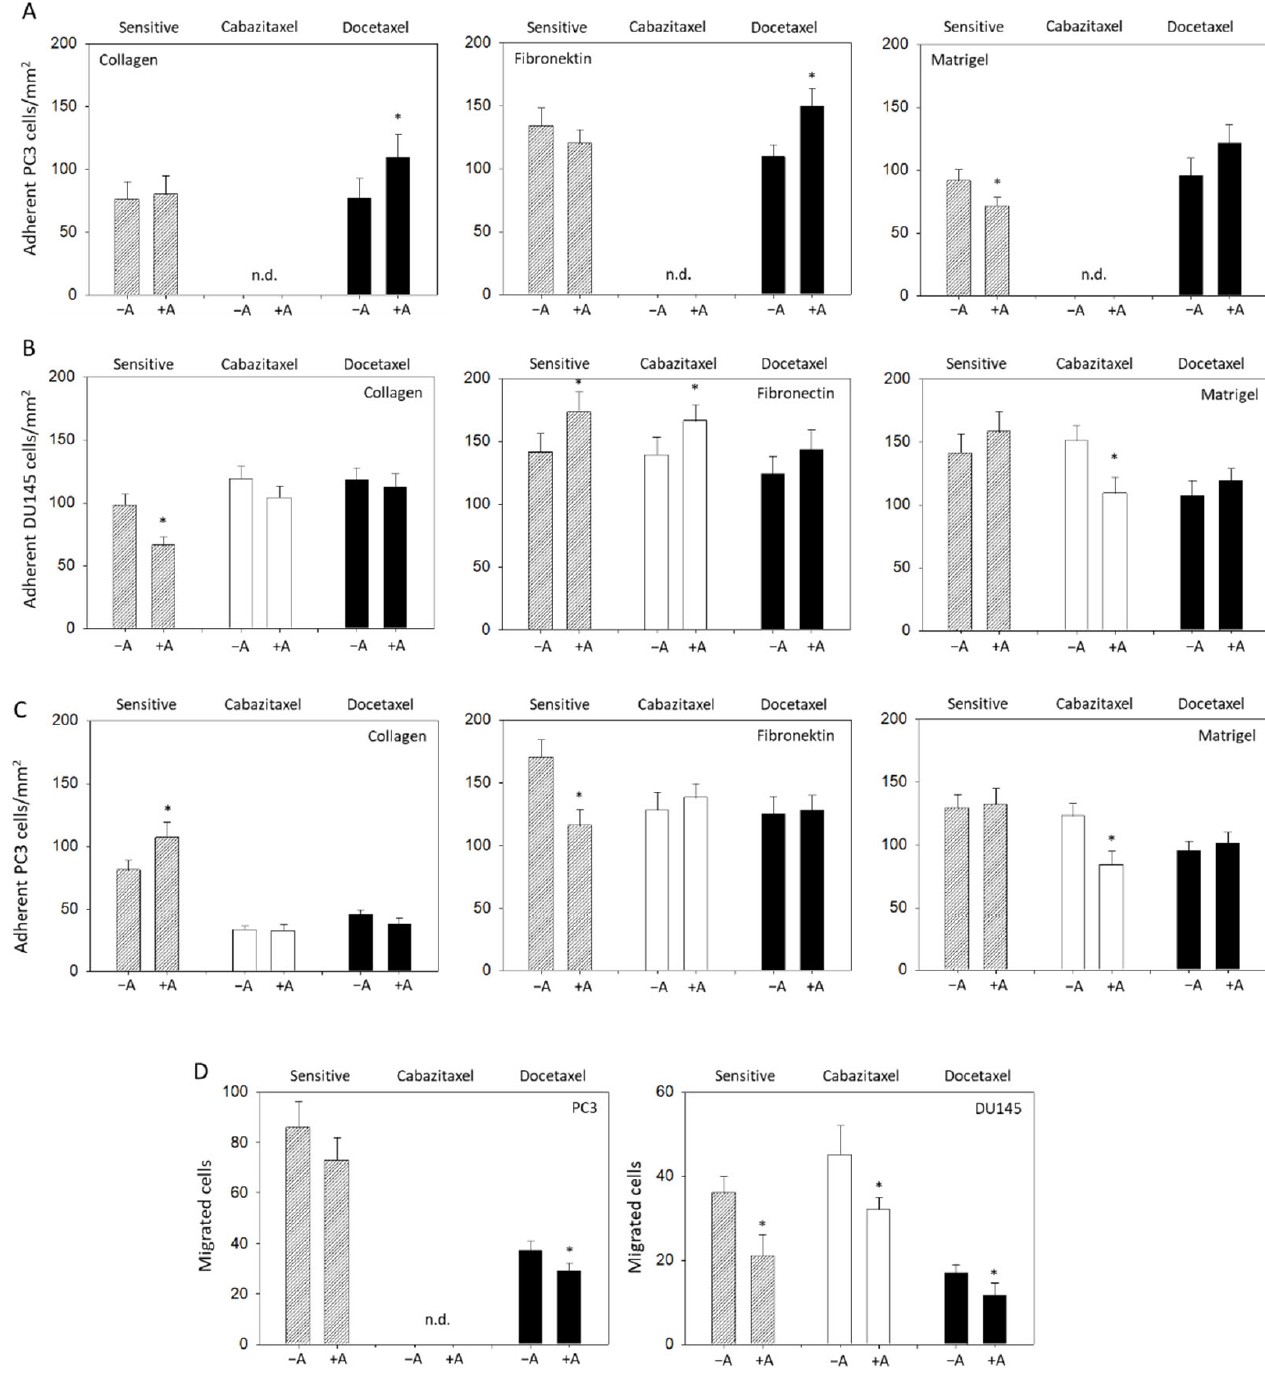
Figure 6. Adhesion of drug-sensitive and drug-resistant PC3 ( A ), DU145 ( B ), and LNCaP cells ( C ) to immobilized collagen, fibronectin, or matrigel. Tumor cells were either treated with amygdalin for 24 h (+A) or remained untreated ( − A). ( D ) Effect of amygdalin (+A) on chemotactic migration of PC3 and DU145 cells. Controls were without amygdalin ( − A). Bars indicate standard deviation (SD). * indicates significant difference to the corresponding control. n = 5. n.d.: not done.